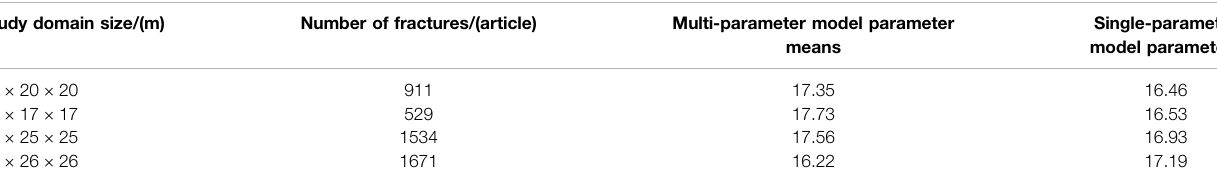
TABLE 2 | The parameter values of the model. Study domain size/(m) Number of